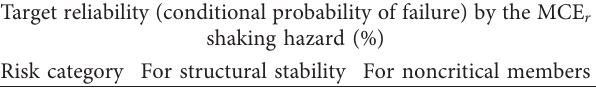
Table 12: Probability of collapse for important members in structural stability and noncritical members